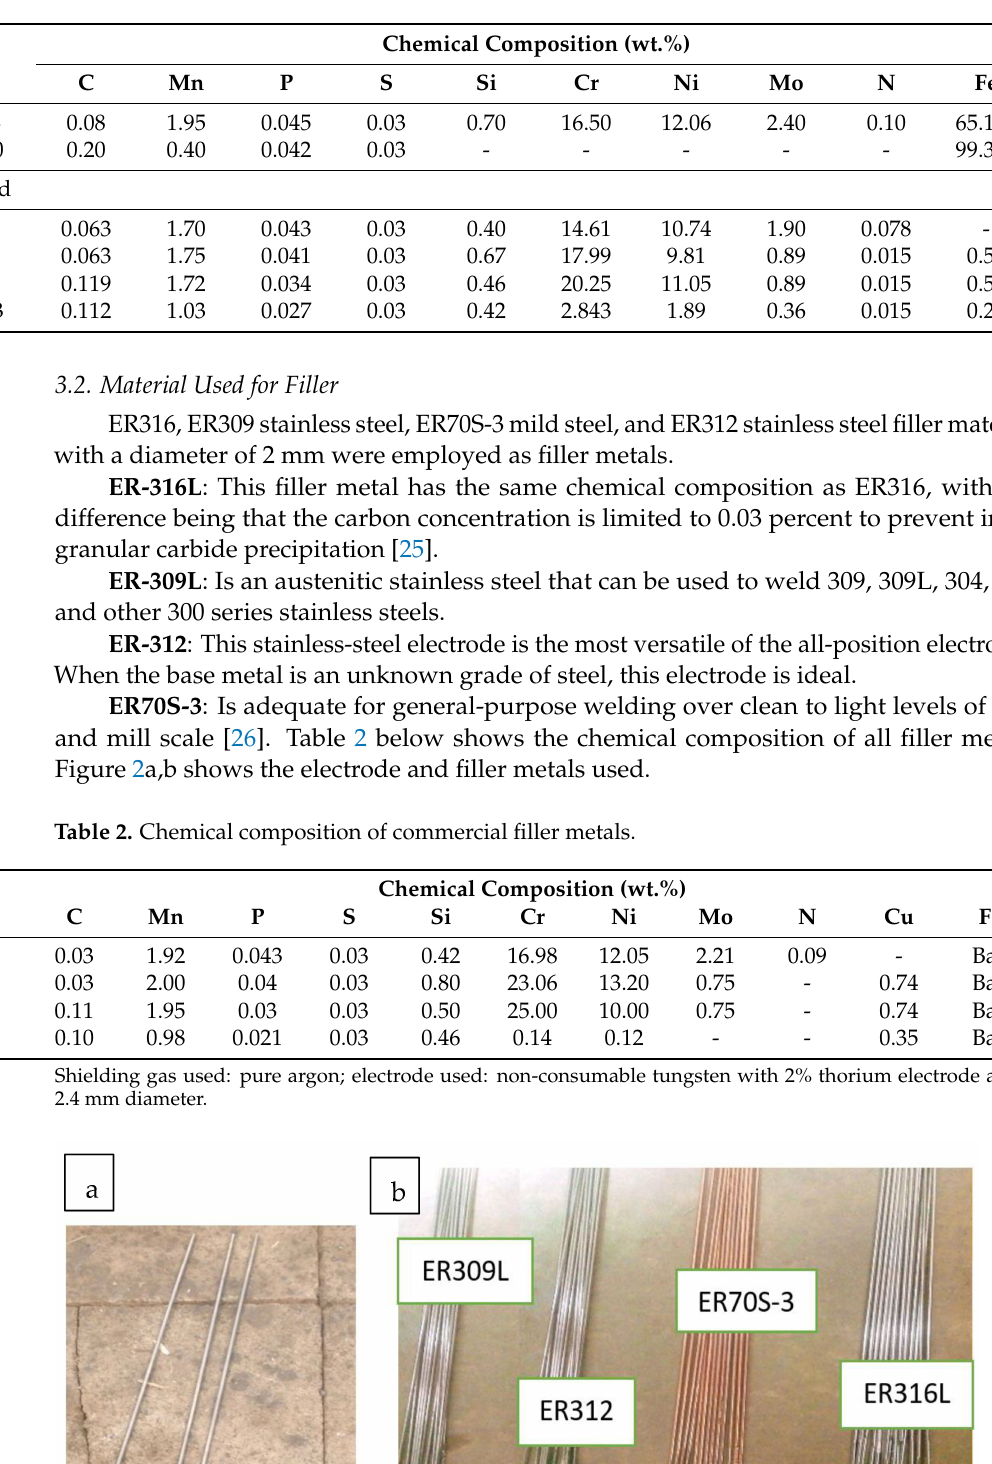
Table 1. Chemical composition of studied base and weld metals.